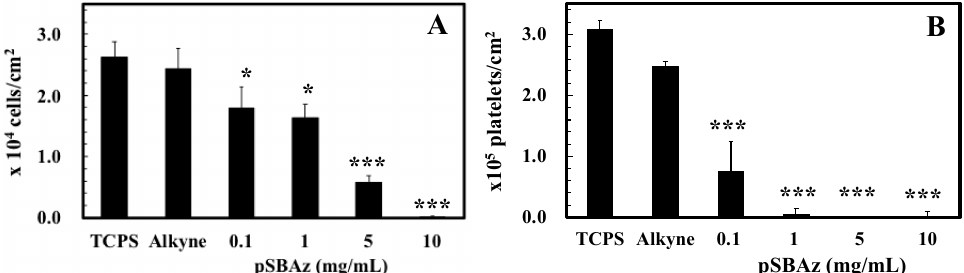
Figure 1. Alkyne-PPX was deposited on tissue culture polystyrene (TCPS) and then conjugated with pSBAz at various concentrations (0.1, 1, 5, and 10 mg/mL). ( A ) 6 h adhesion of L929 cells and ( B ) 1 h adhesion of platelets, on the various substrates. Value = mean ± standard deviation, n = 5. *, *** represent p < 0.05 and 0.001, respectively, compared to the adhesion of L929 cells or platelets to the corresponding